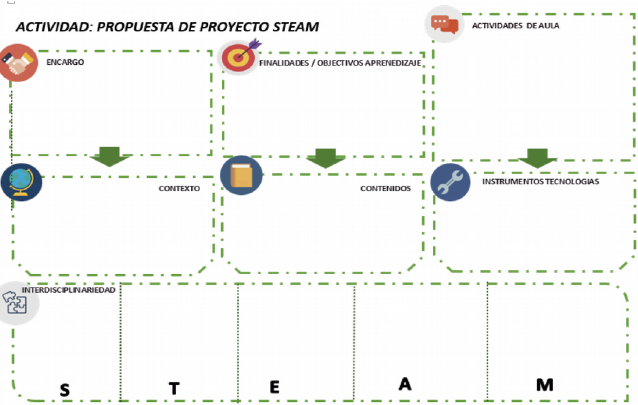
Figure 1. Canvas to design STEAM